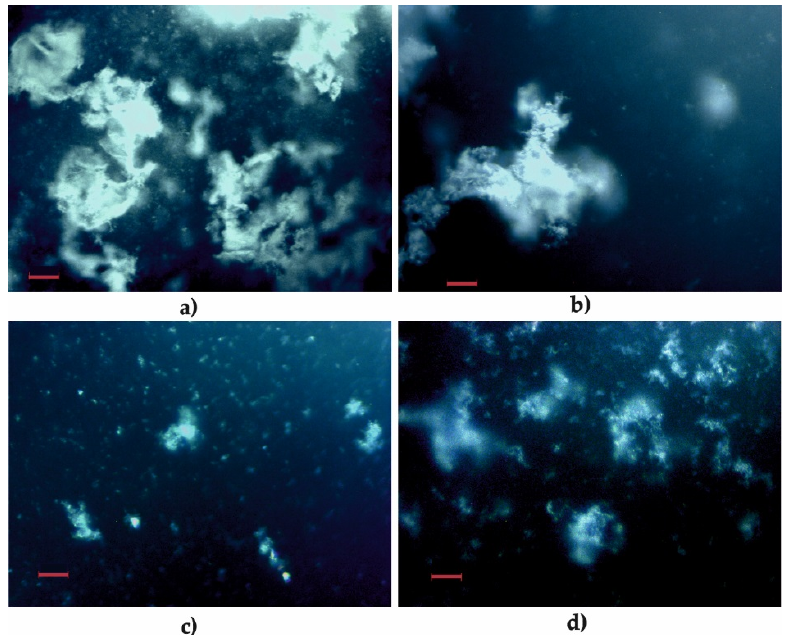
Figure 2. Optical microscope images of several tested mixtures: ( a ) C12NC2 / dsDNA; ( b ) C12NC7 / dsDNA; ( c ) C12NC9 / dsDNA; and ( d ) C12NC12 / dsDNA in p / n = 4. Magnification was 200 × . Scale bars represent 50 µm.